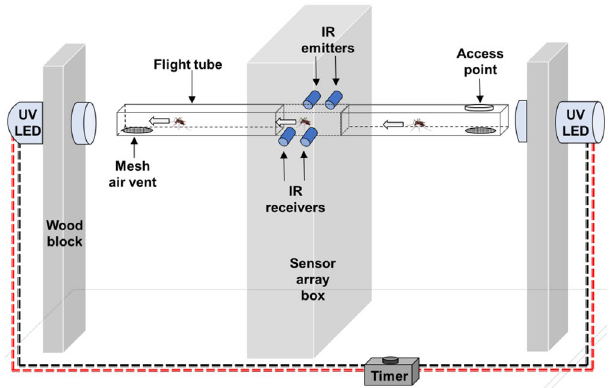
Figure 3. Device for recording mosquito wingbeats. Female mosquitoes pass between IR emitters and receivers, attracted back and forth through the flight tube by alternating UV LED flashlights, controlled by a